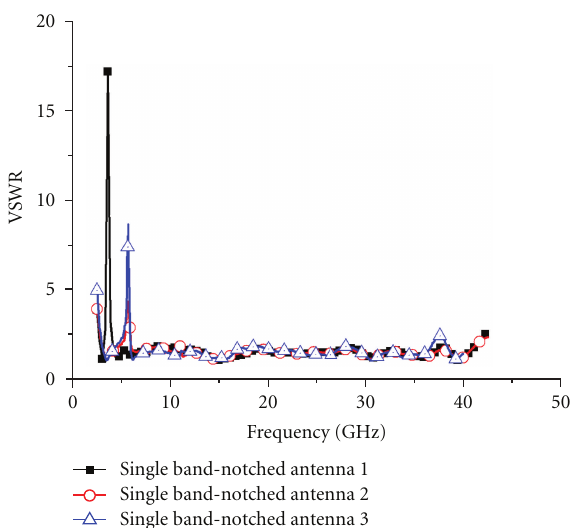
Figure 3: The simulated VSWR results of the single band-notched antennas.